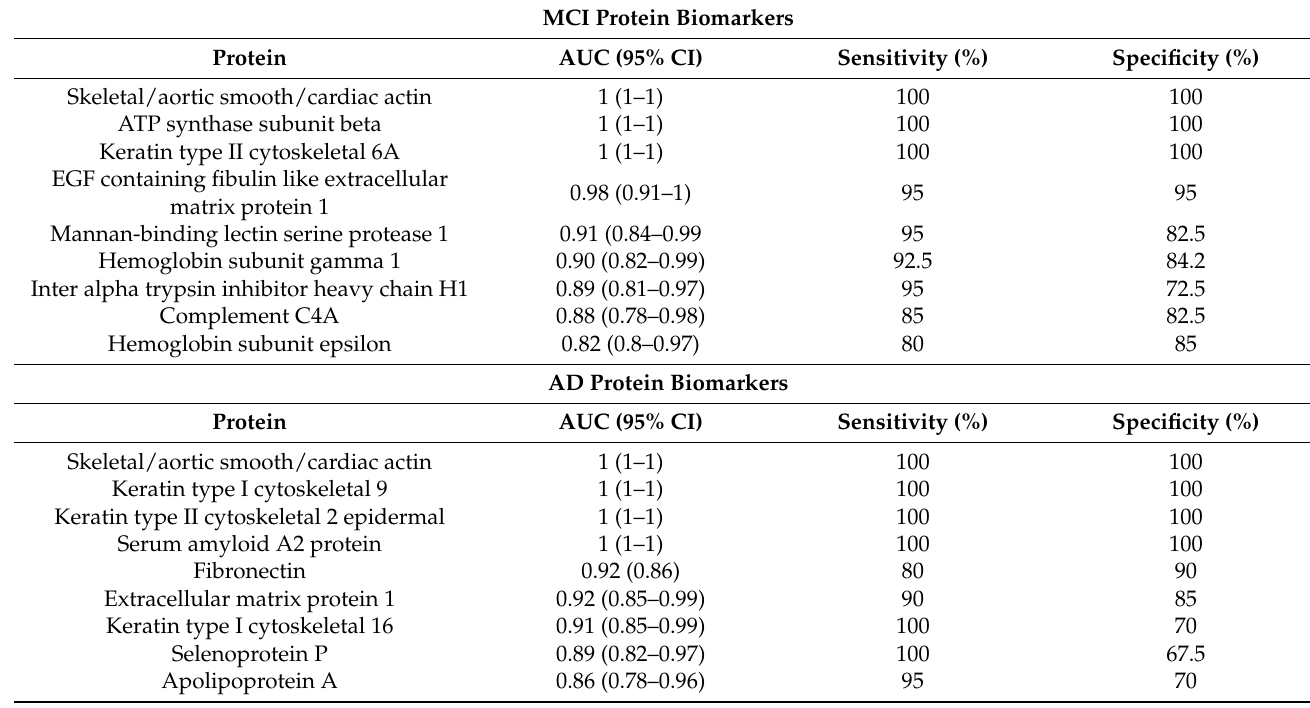
Table 2. Top protein biomarkers for clinical classification of MCI and AD adjusted for cofounders. MCI Protein